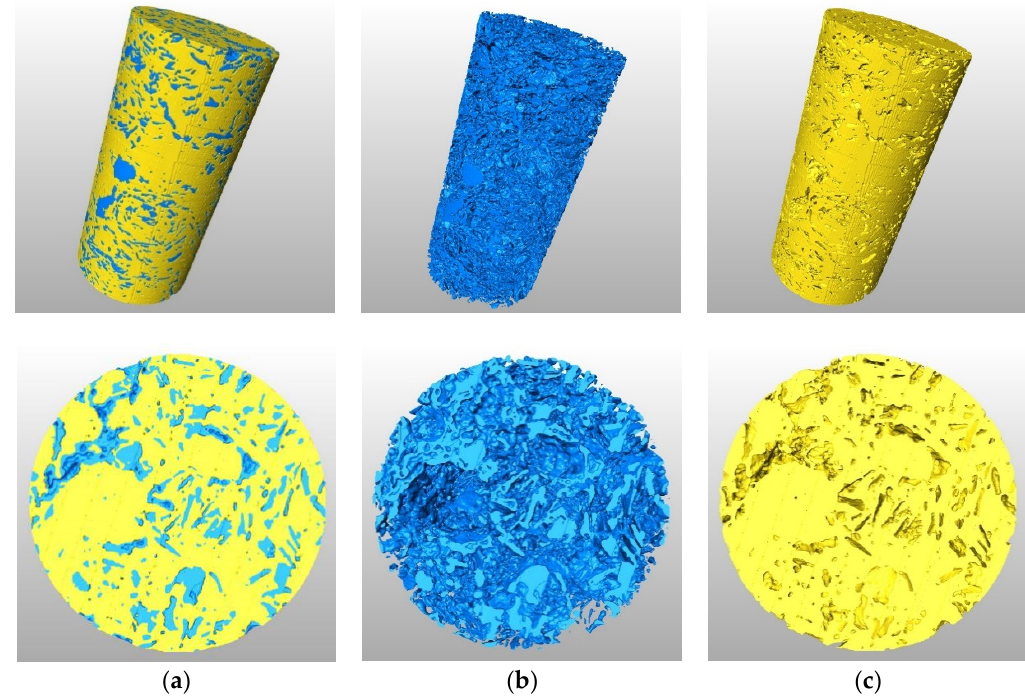
Figure 7. The 3D reconstructed model of sample A. ( a ) Total. ( b ) Pore network. ( c ) Solid.